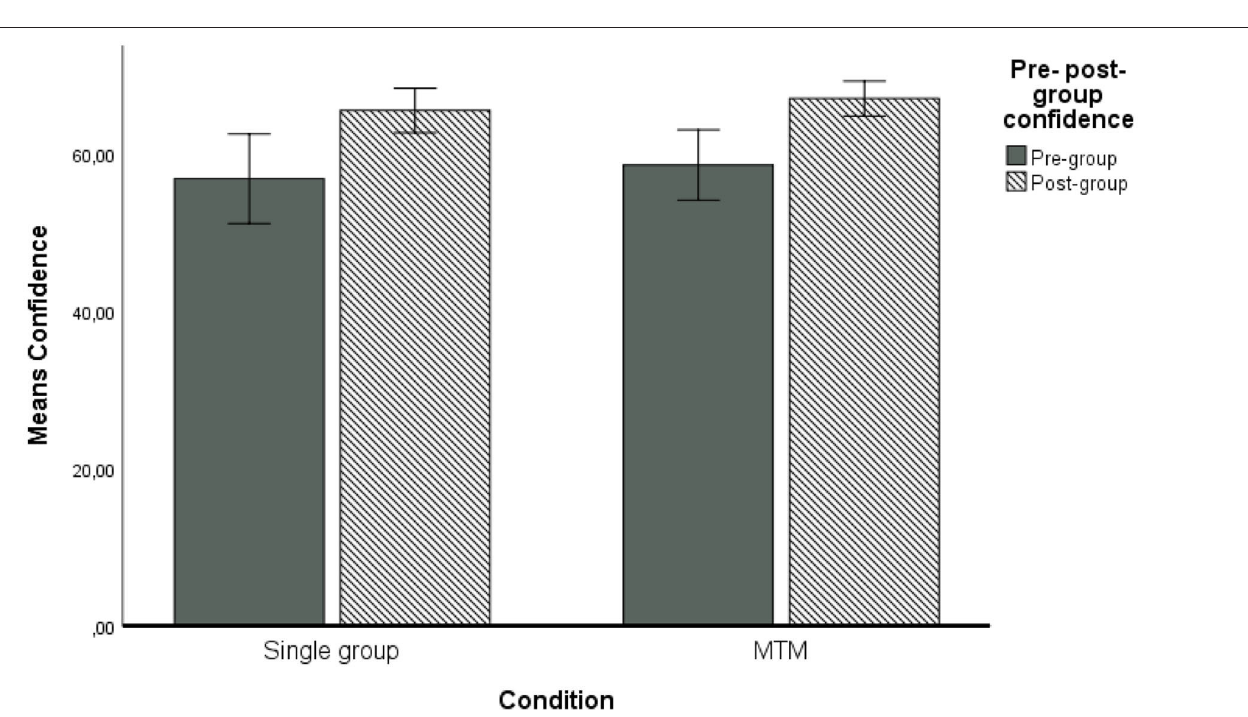
confidence with F (1, 99) = 45.25 ( p < 0.0001) η ² =